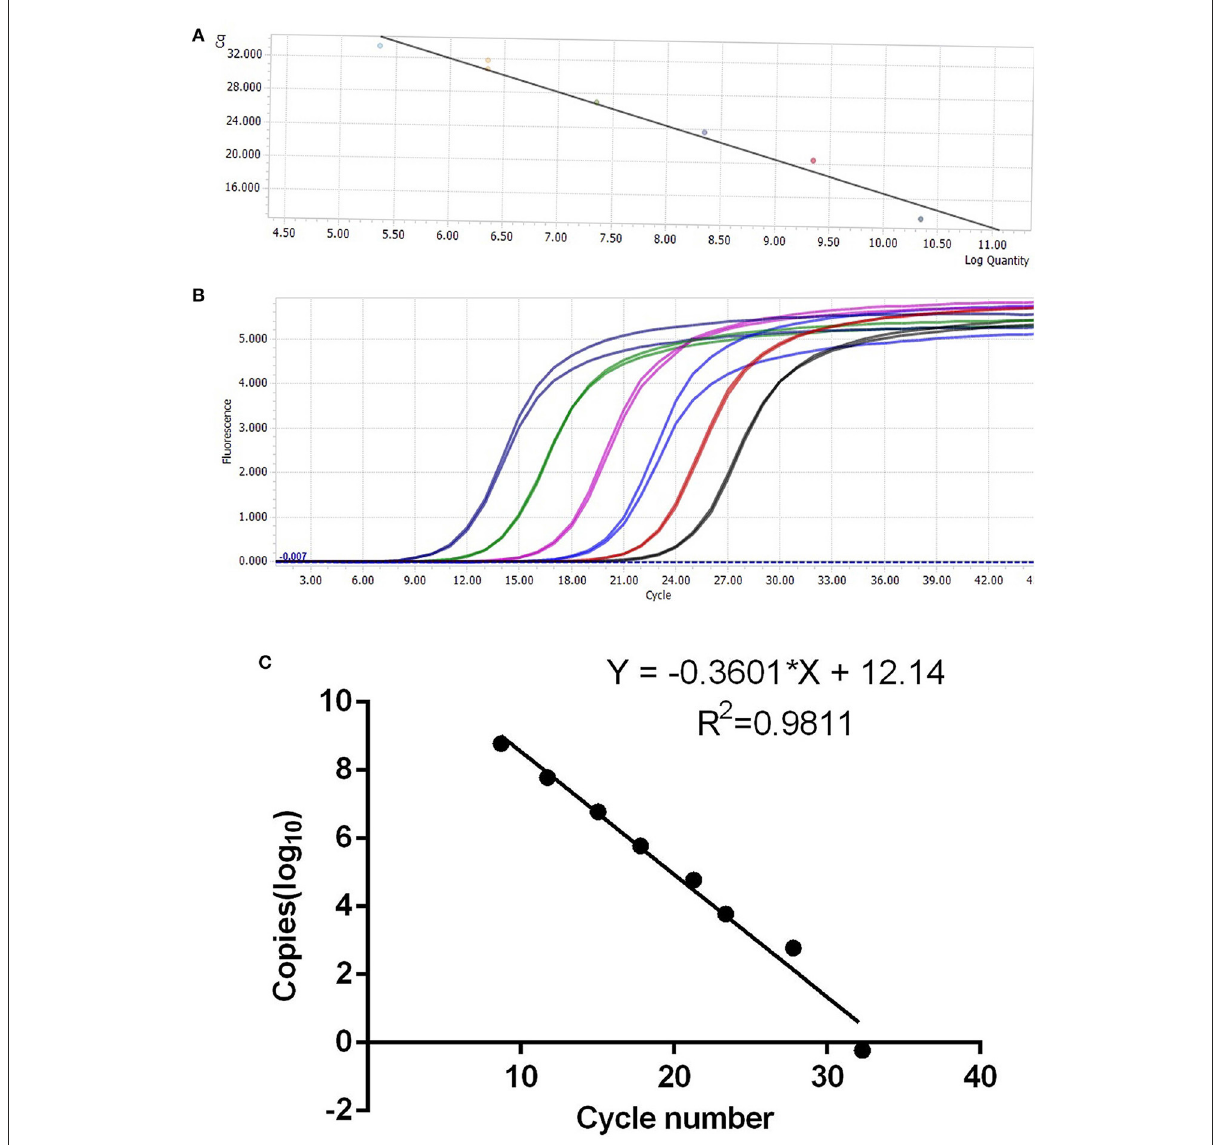
FIGURE3 Establishment of IFN- ε SYBR fluorescence quantitative polymerase chain reaction. (A,B) Standard curve based on different dilution gradients of plasmids. (C) Standard curve for the correlation between copy number and cycle threshold value.